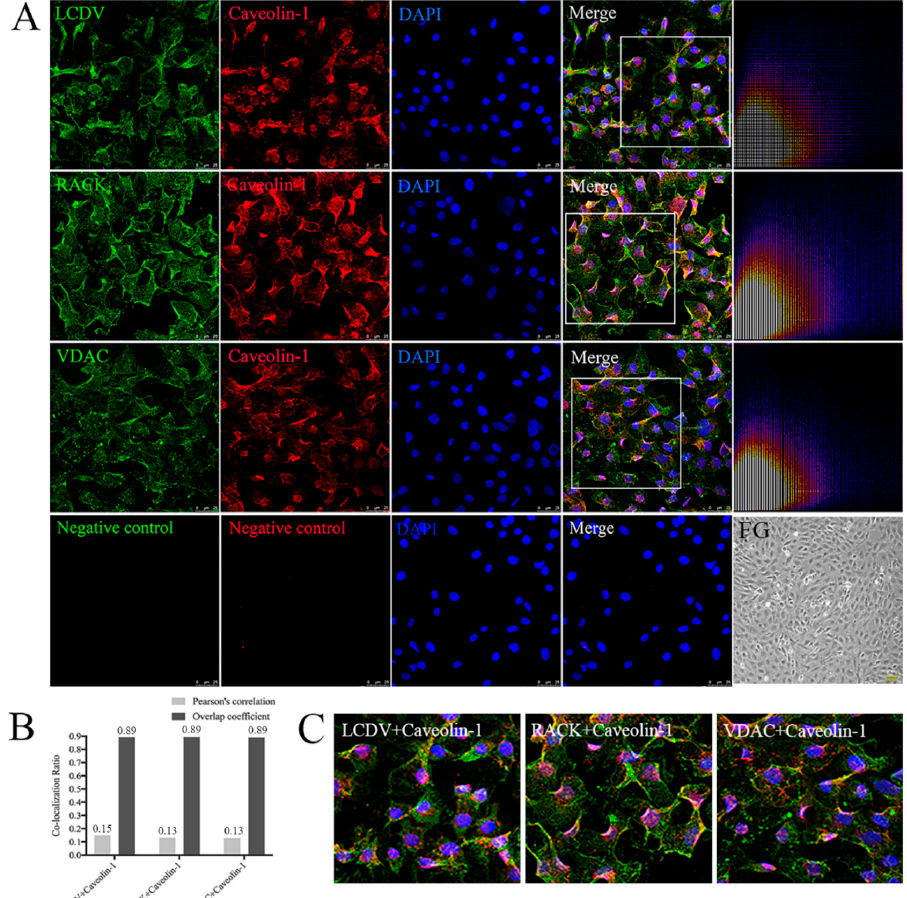
Figure 11. Co-localization of LCDV, VDAC2, and RACK1 with caveolin-1. ( A ) The co-localization of LCDV, VDAC2, and RACK1 with caveolin-1 analyzed by confocal microscopy; scatter plots represent the co-localization analysis of the merged images using ImageJ software, the diagonal shape of the scattered blots indicated a high level of co-localization, bars = 25 μ m. Uninfected FG cells were shown as a control, bars = 100 μ m. ( B ) Pearson’s correlation and overlap coefficients of the merged images analyzed by ImageJ software. ( C ) Higher magnification on framed areas of merged figures in ( A ). Rabbit pre-immune serum paired with mouse pre-immune serum instead of primary antibodies served as a negative control. The virus inoculation was conducted at 22 °C for 2 h.